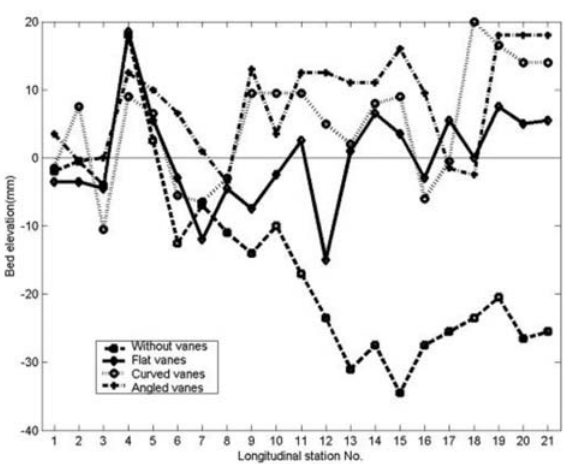
Fig. 11. Longitudinal bed profiles 3-cm from outer bank of 3- vanes in a row in zigzag pattern on 900-bend.